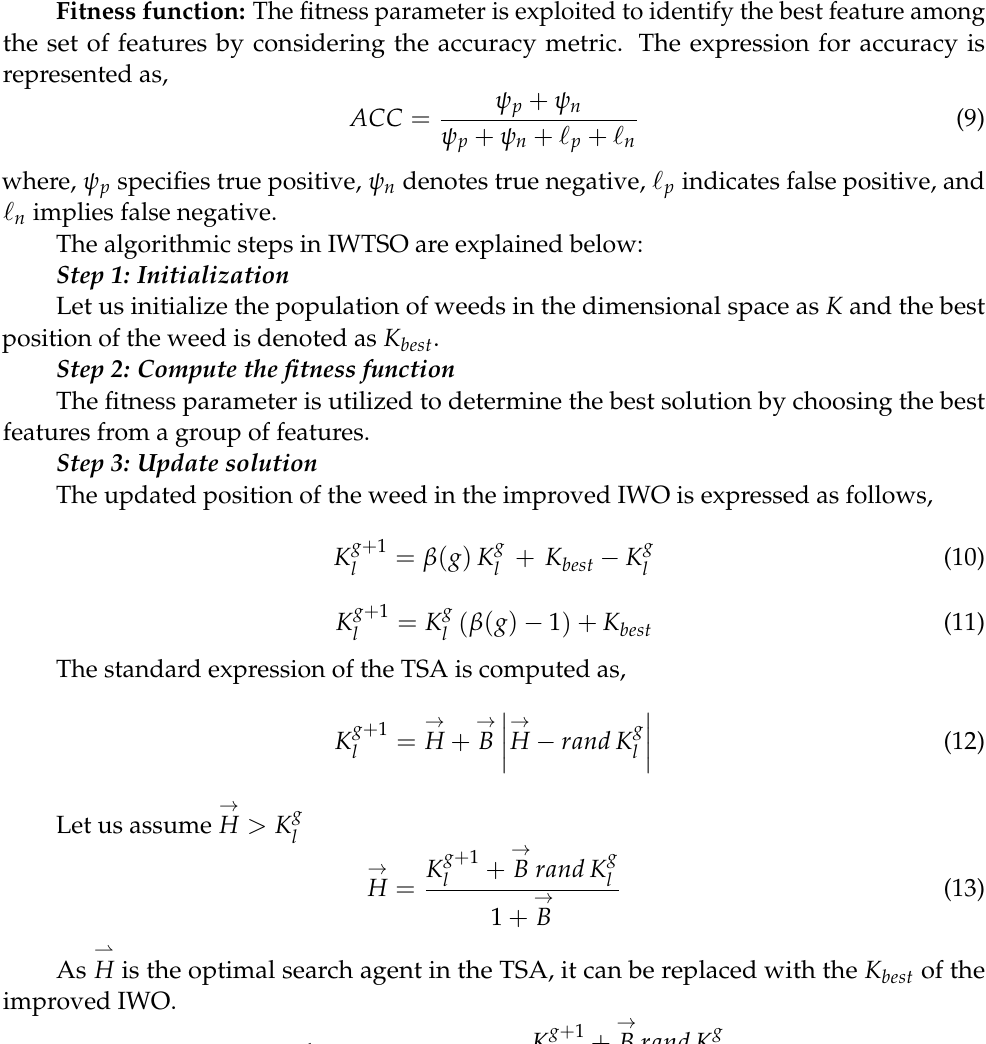
Figure 2. Solution Figure 2. Solution encoding.